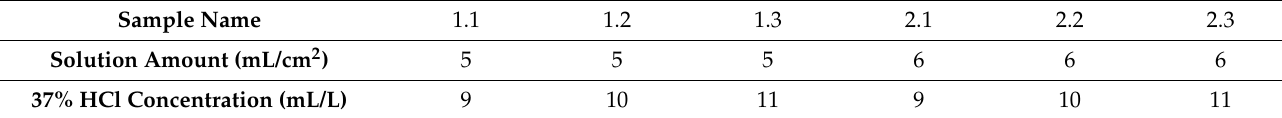
Table 3. Varying testing parameters of the ISO 11846:1995-based tests.